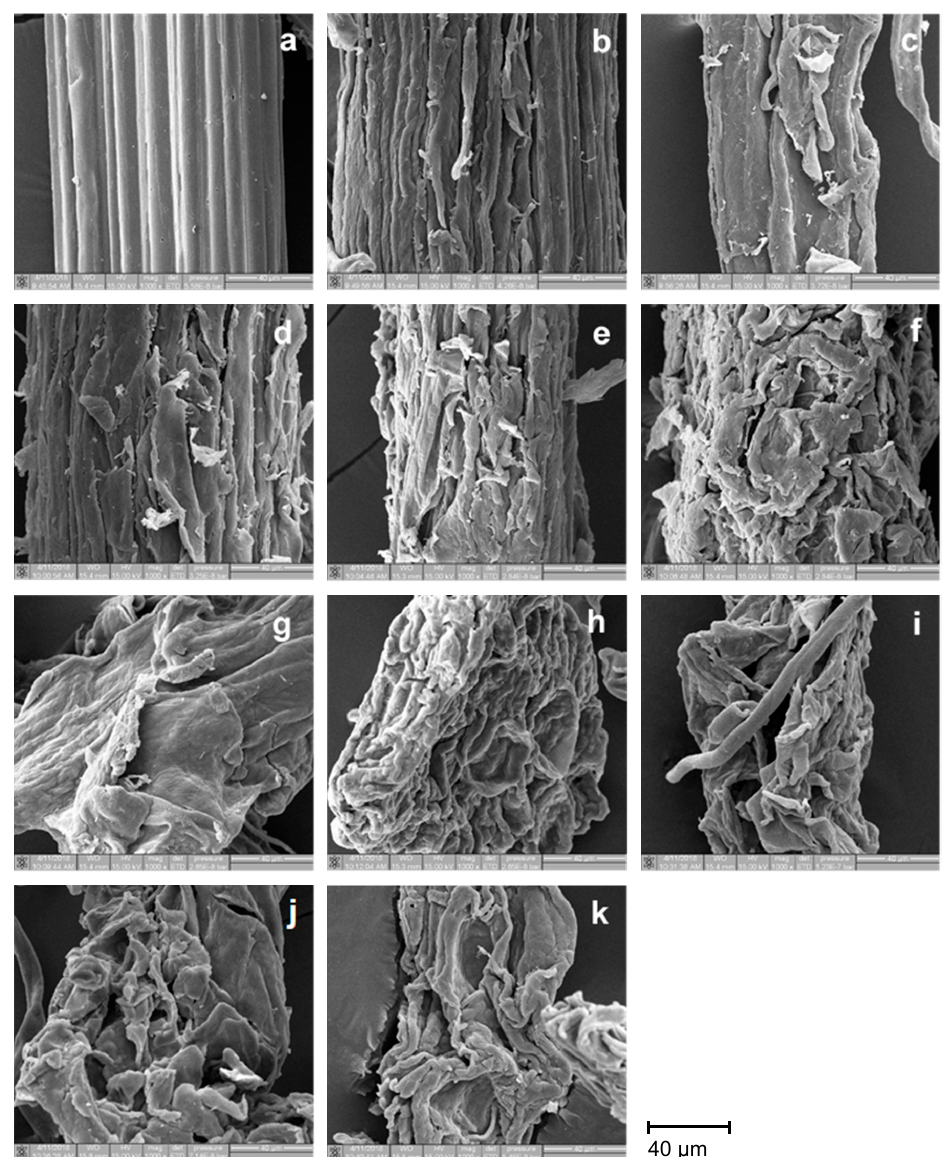
Figure 5. SEM images of ( a ) bagasse, ( b ) cellulose-b-0, ( c ) cellulose-b-10, ( d ) cellulose-b-20, ( e ) cellulose-b-30, ( f ) cellulose-b-40, ( g ) CMCb-0, ( h ) CMCb-10, ( i ) CMCb-20, ( j ) CMCb-30, and ( k ) CMCb- 40.